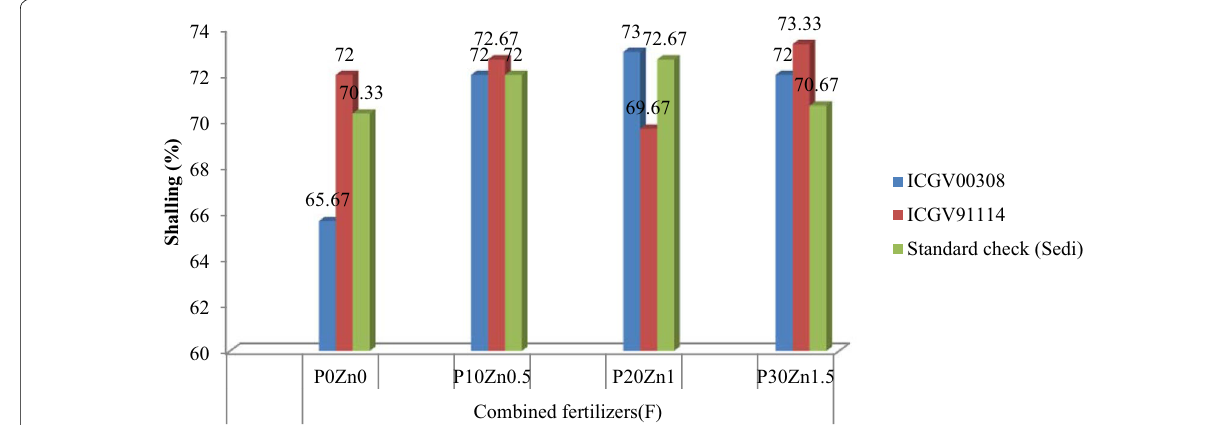
Fig. 3 The interaction effect of genotypes and PZn fertilizer on shelling percentage of groundnut